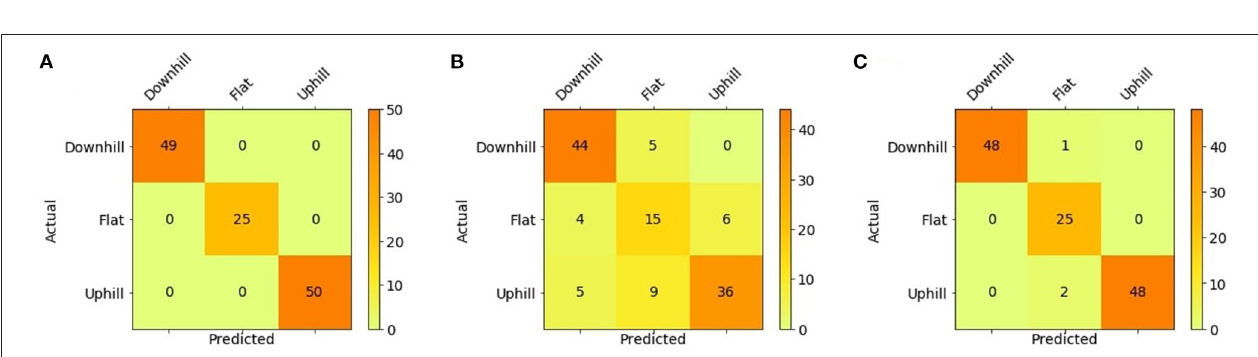
FIGURE 9 | Echo state network structure extended to include the terrain classification task. The input layer includes eight torque signals coming from the Hip 2 and the Knee joints for all the legs, and the output layer contains two readout maps which are respectively dedicated to estimating the GRF in the four legs and classifying the terrain type into three categories (flat ground, uphill, and downhill). In this last case, a low-pass filter was adopted.